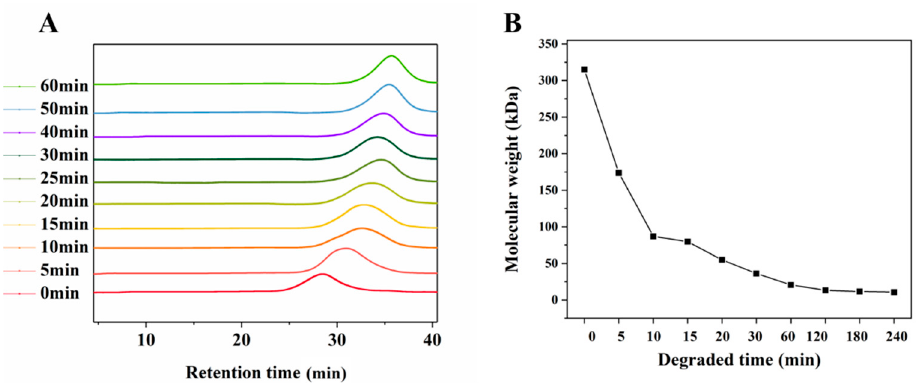
Figure 1. GPC profile ( A ) and changes of molecular weights ( B ) of degraded LJP.